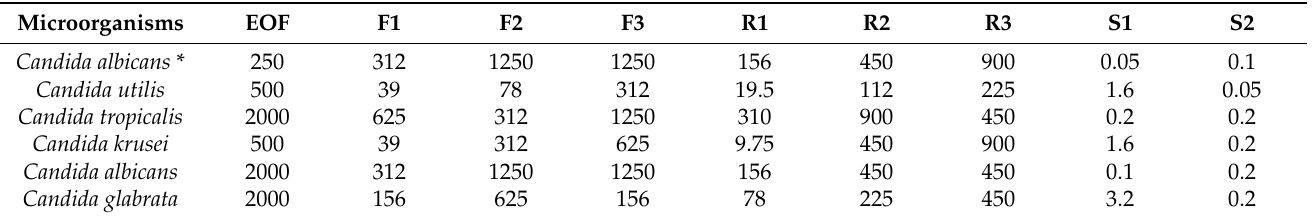
Table 3. Anticandidal activity of the fruit essential oil, fruit, and root extracts of Ferula drudeana (MIC, µ